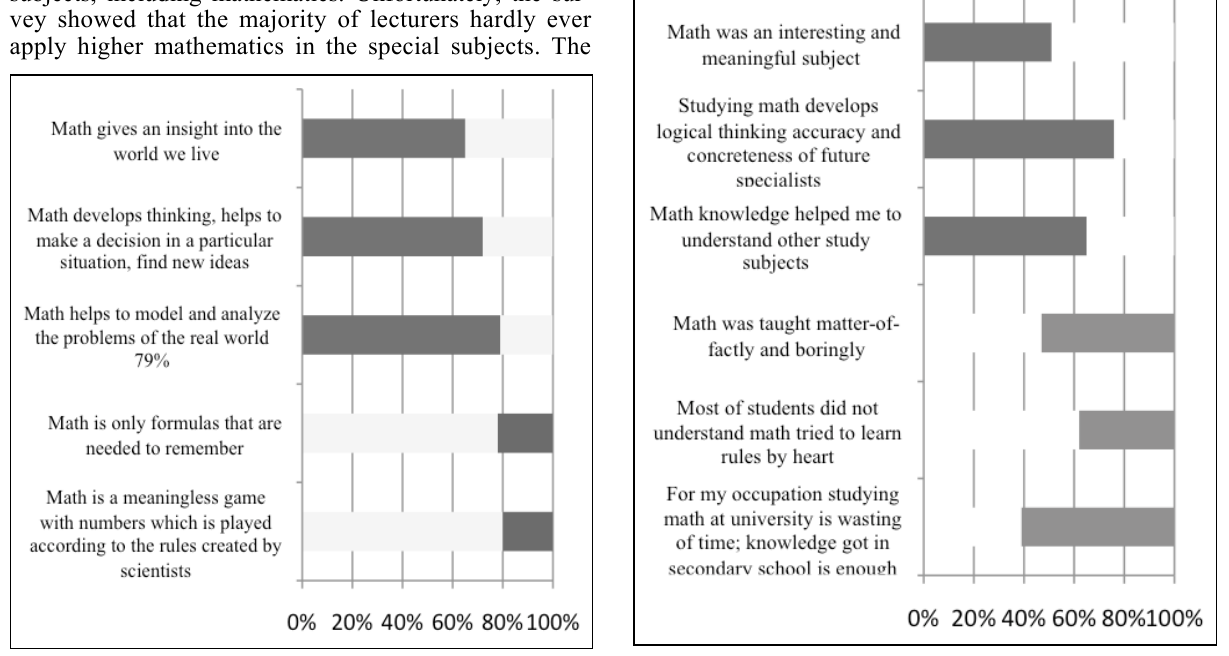
Figure 8. Mathematics teaching at